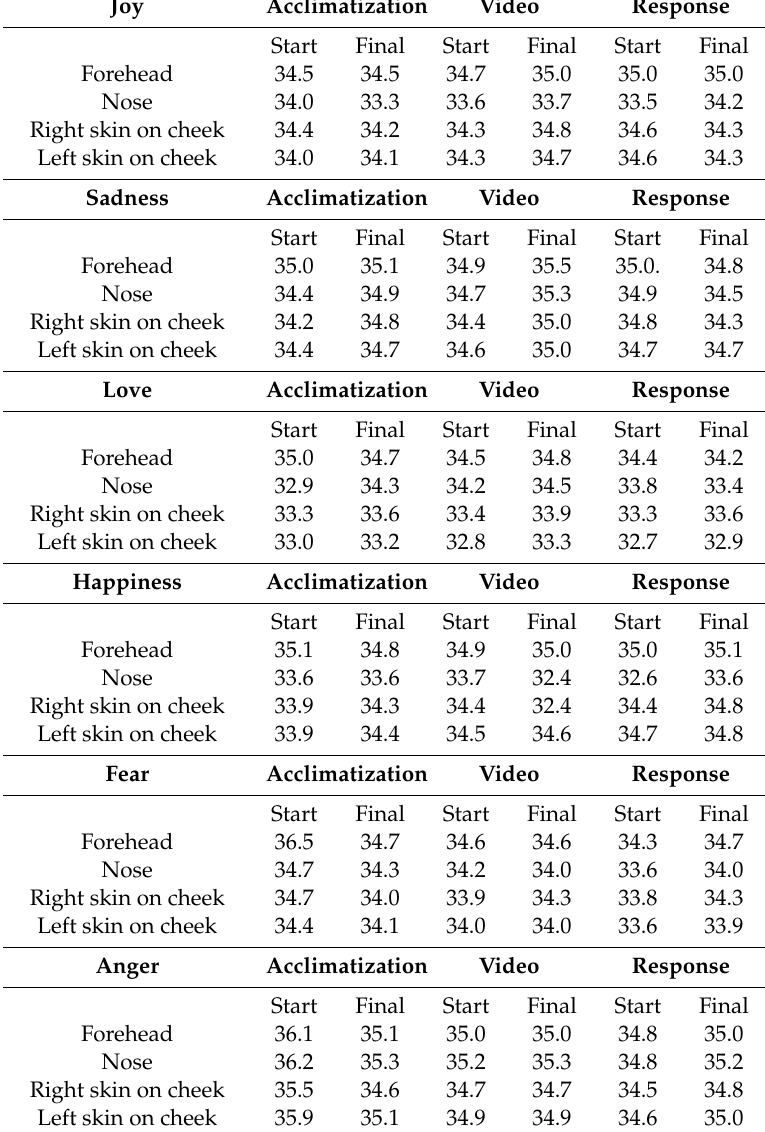
Table 4. Facial average temperatures in each phase for the evaluated Regions of Interest